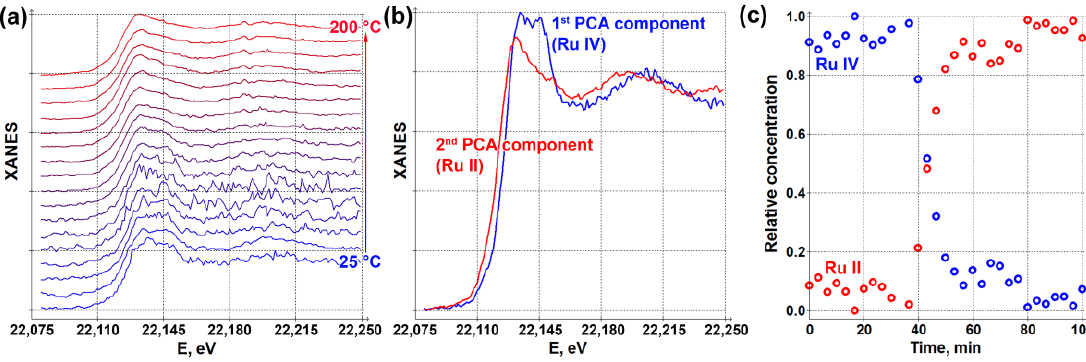
Figure 7. ( a ) Ru K ‐ edge XANES spectra acquired during the heating of nanocatalyst. ( b ) The spectra of two components extracted by target matrix transformation of PCA components. ( c ) Concentration profiles corresponding to Ru(IV) and Ru(II) components.